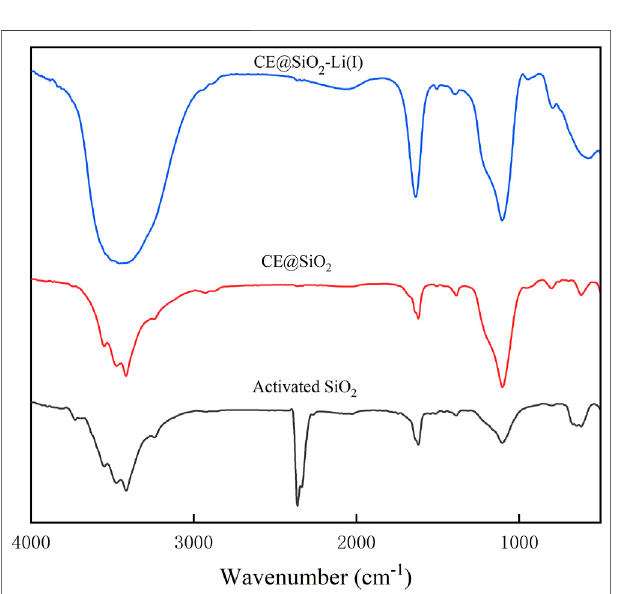
FIGURE 3 | Infrared spectra of activated SiO 2 and CE@SiO 2 before and after adsorbing Li(I).